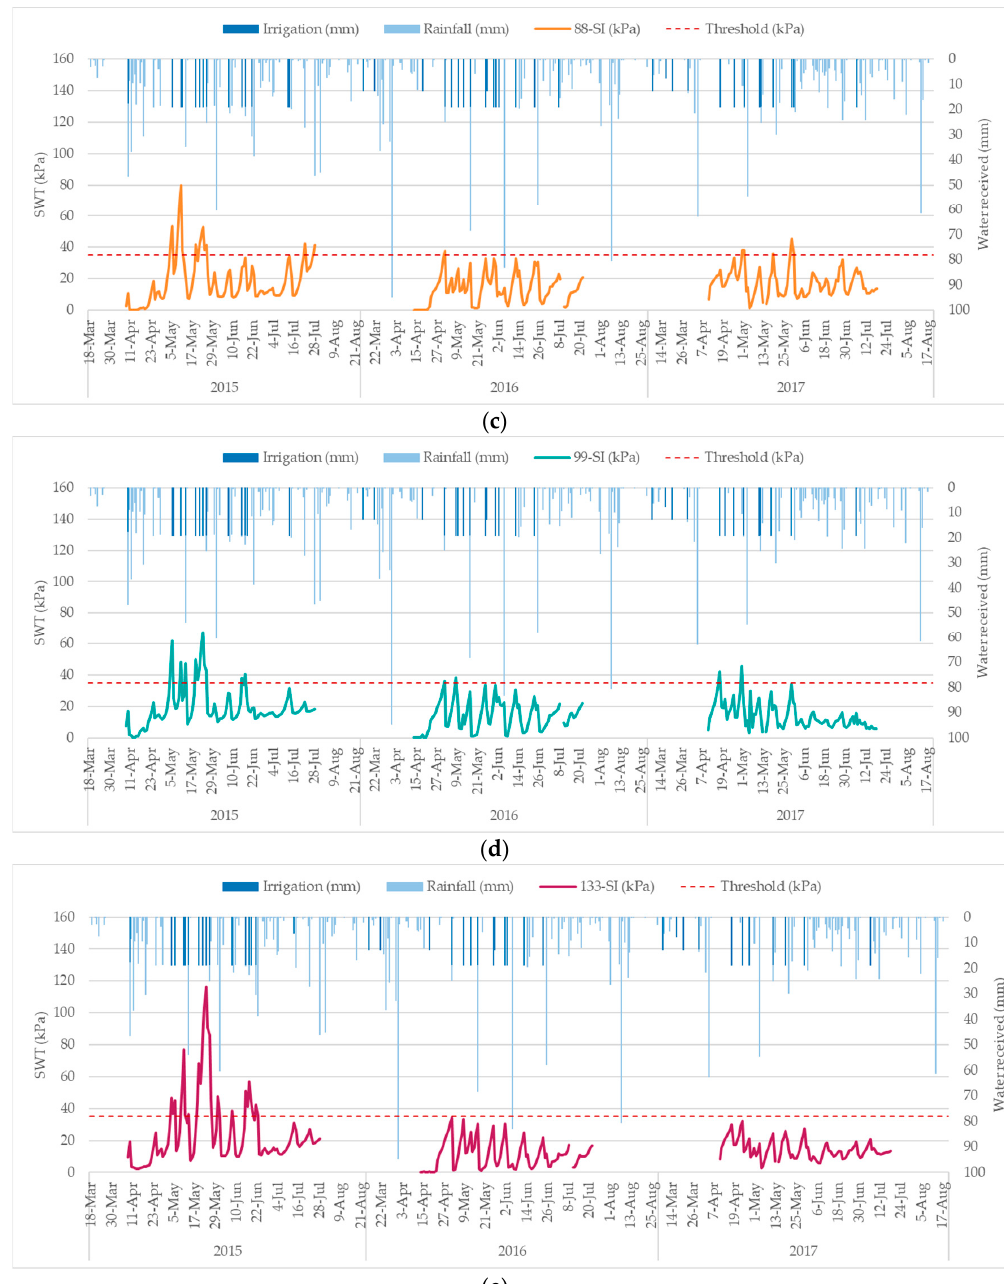
Figure 7. Daily average SWT data for the dryland treatment ( a ) 69K plants/ha, and the irrigated treatments ( b ) 69K plants/ha, ( c ) 88K plants/ha, ( d ) 99K plants/ha, and ( e ) 133K plants/ha in conservation tillage and total amount of water received through applied irrigation or rainfall during 2015, 2016, and 2017 growing seasons.